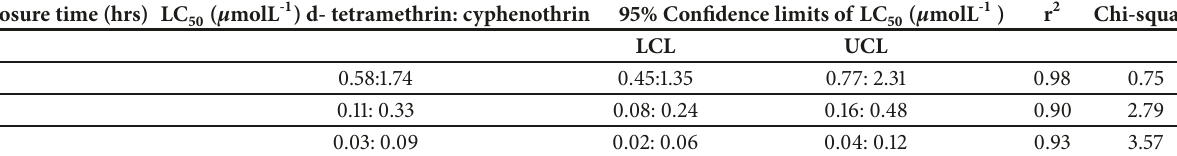
Table 1: LC 50 values of a binary mixture of d-tetramethrin and cyphenothrin at different time intervals.